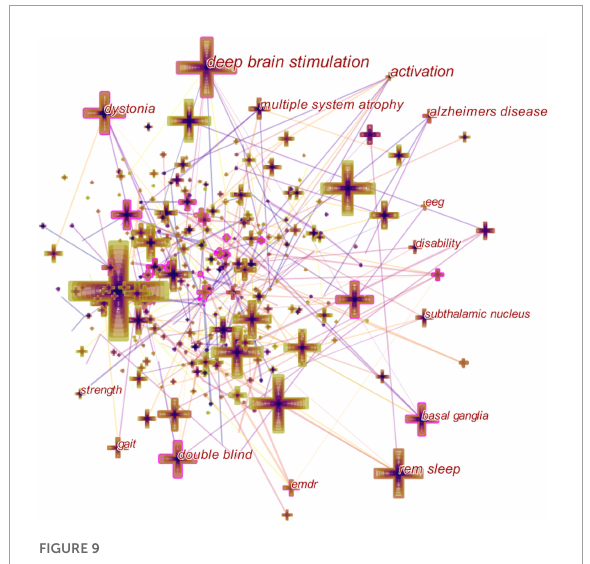
FIGURE9 Keyword map of exercise for movement disorders.